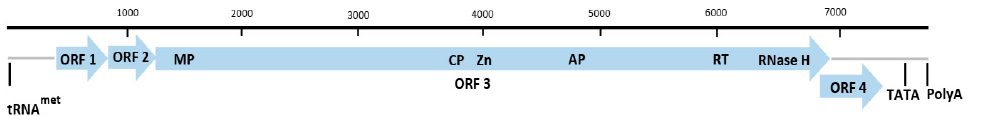
Figure 5. Schematic representation for the linearised genome organization of species Dioscorea nummularia-associated virus (DNUaV) genus Dioscovirus , family Caulimoviridae . ORF1 encodes P1 protein (function unknown), ORF2 encodes P2 (function unknown), ORF3 encodes polyprotein P3 (VMP, CP, AP, RT, RNase H1) and ORF4 encodes P4 (TAV). tRNA met binding site designated as the origin of the circular genome.